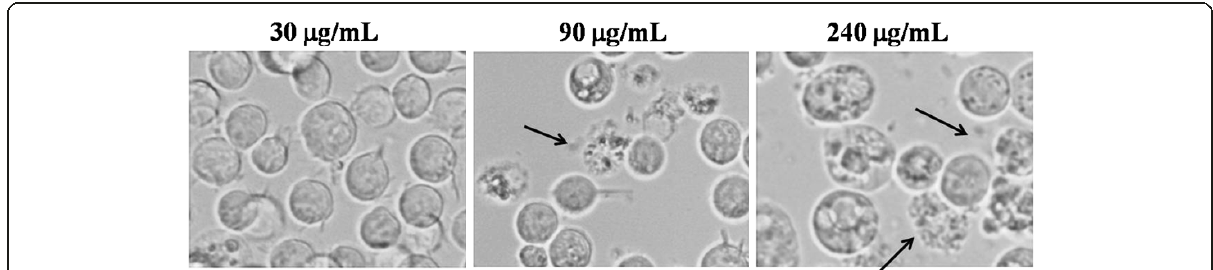
Figure 4 Fenugreek extract induced plasma membrane rupture and total cell lysis. Increasing concentrations of fenugreek extract after 48 hr caused morphological changes leading to cell death. Disappearance of cell shape by rupture of plasma membrane was seen at higher concentrations of fenugreek extract. Arrows point to cellular membranes undergoing rupture. Pictures represent inverted light microscopic images taken at 400x magnification.